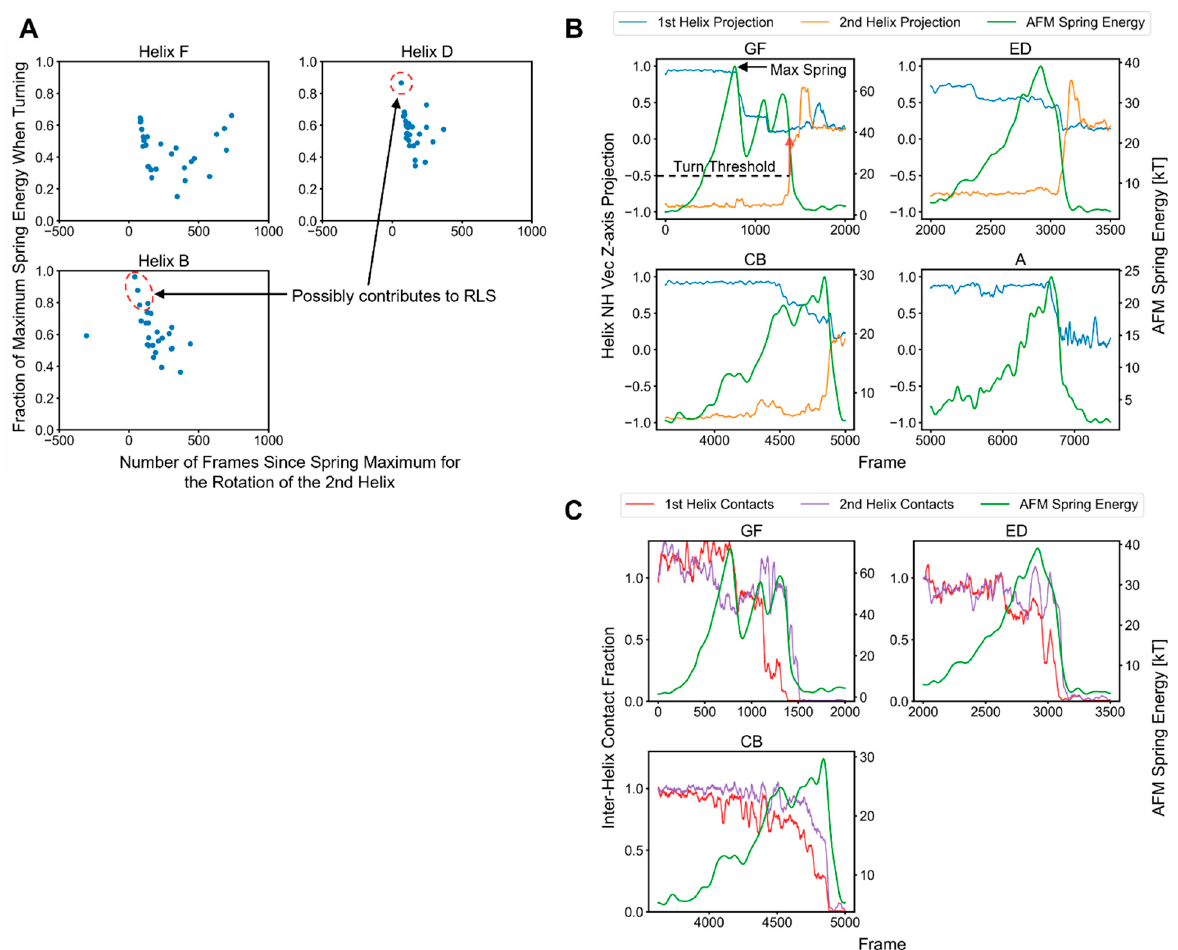
Figure 7 . Deconstructing the contributions of non-H-bond interactions to the rupture events. ( A ) The proximity of the second helix’s turning point to the maximum AFM spring energy and the fraction of the spring energy at which this helix turned. Each data point corresponds to one of the 28 replicas. The red circles identify where the turning of the second helix might contribute to the main rupture event (using an 80% cutoff). ( B ) Helix NH bond vector projections onto the z-axis for a particular replica in comparison to the spring energy. The data were smoothed with uniform and Gaussian filters (Methods) unlike those in Figure 6. ( C ) Fractions of the inter-helix contacts of the first and second helices to the other bR helices in relation to the AFM spring energy. These were referenced to the number of contacts at the start time shown for each panel. Helix A is omitted because it lacked a partner at the time of its rupture.